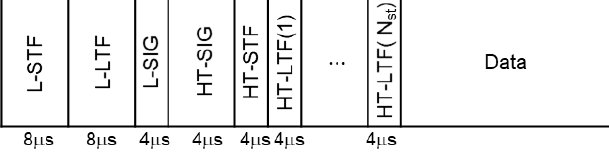
Figure 1. Frame format of IEEE 802.11n hybrid